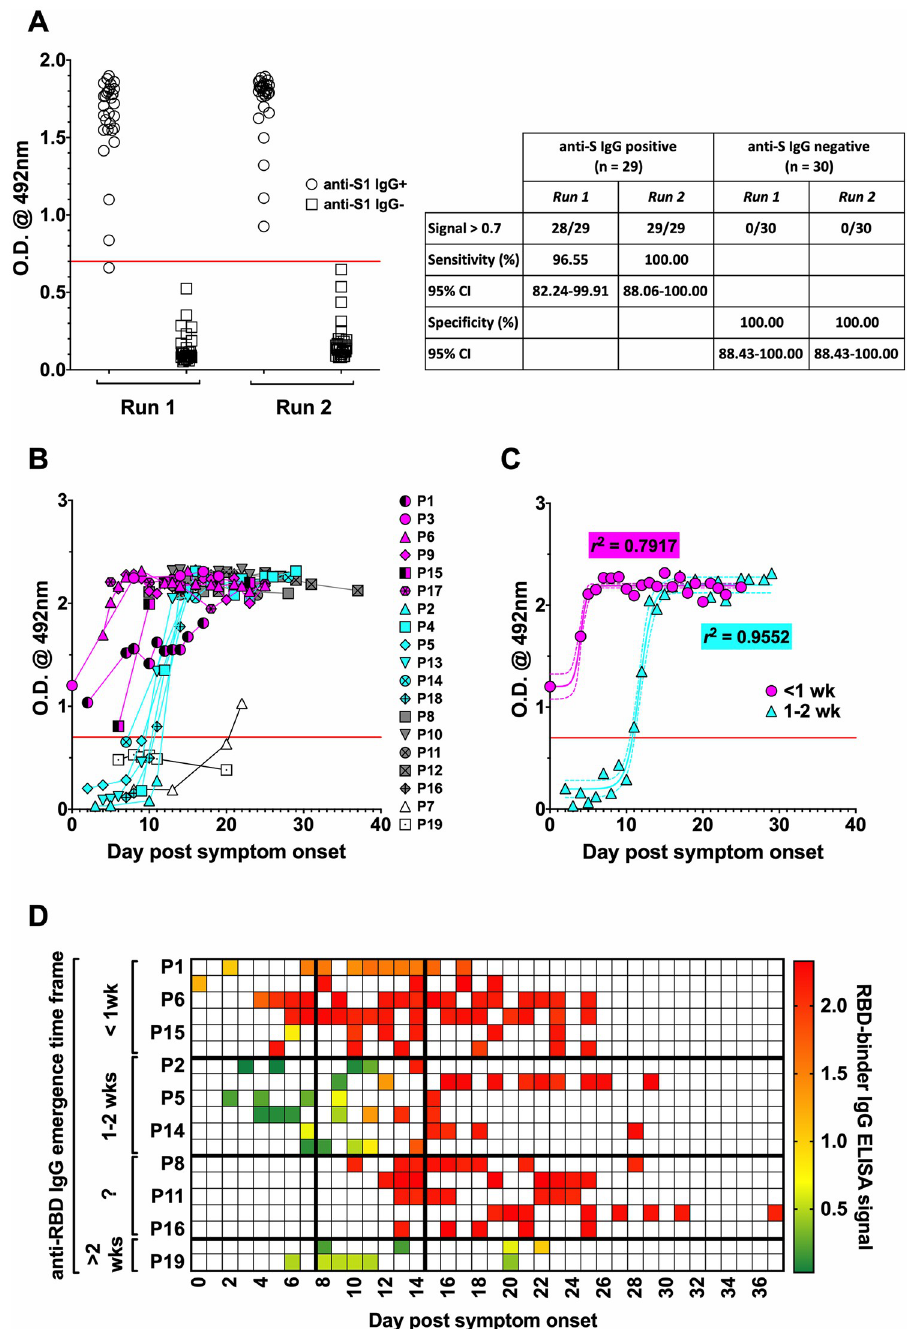
Fig 2. Temporal emergence of anti-RBD IgG antibodies. Serum samples collected from the cohort members over time were analysed for anti-RBD IgG by an ‘in-house’ ELISA. ( A ) The anti-RBD IgG ELISA was optimised by assaying sera previously shown to be either positive (n = 29) or negative (n = 30) for anti-S1 IgG by the EuroImmun assay; each serum was assayed in duplicate (means are depicted), and the optimisation was based on data from two separate runs. The calculated sensitivity and specificity of the anti-RBD IgG ELISA are described in the table. ( B ) Individual time- course data and ( C ) best-fit curves for the emergence of RBD-binding IgG occurring after < 7 days or between 7–14 days pso. In solid red line is the cut-off (0.7) for negative/positive seroreactivity. Patients #1 and #15 were considered outliers and were therefore excluded from best-fit curve analyses. In C –dashed lines indicate 95% CI ranges; r 2 values describe tightness of fit. ( D ) Data from B presented as a heat-map. ‘?’ indicates undetermined seroconversion time frame.